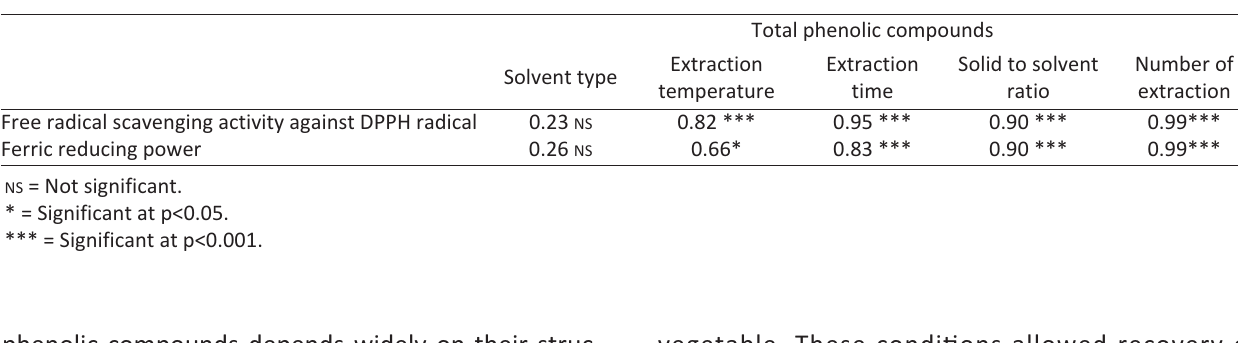
Table 2 ­ Pearson correlations coefficient between different assays under influence of extraction conditions